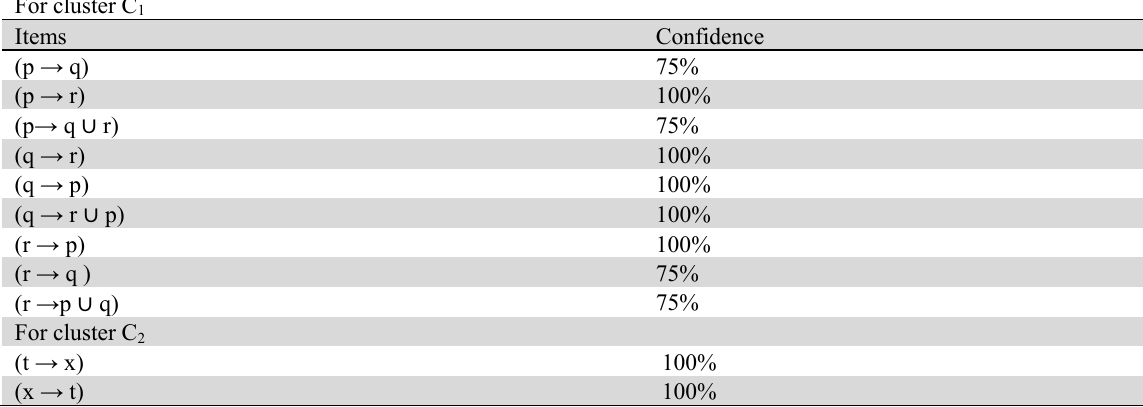
Confidence of frequent item-set in Cluster C 1 and Cluster C